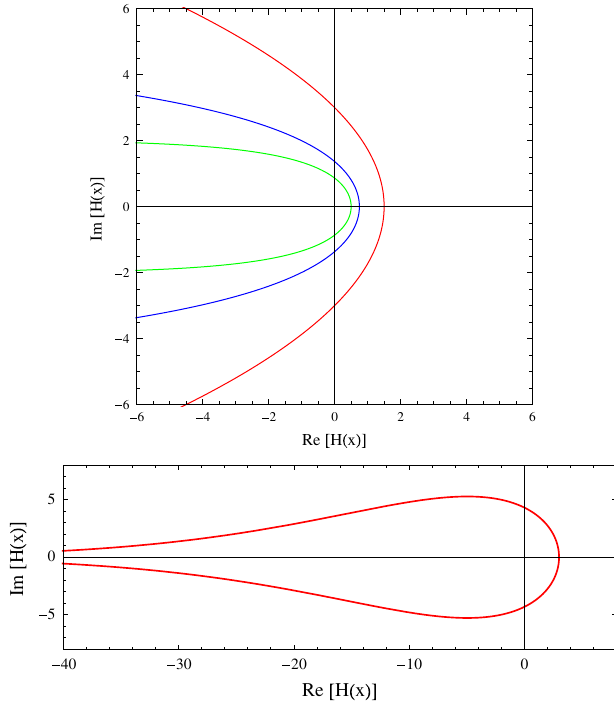
FIG. 5. (Color) (Upper) Stability diagrams for galaxy distribu- tions are plotted in red, blue, and green for Cases 1, 2, and 3, respectively. (Lower) Case 4: Function H ð x Þ represents the right- hand sides of the dispersion relations for the four